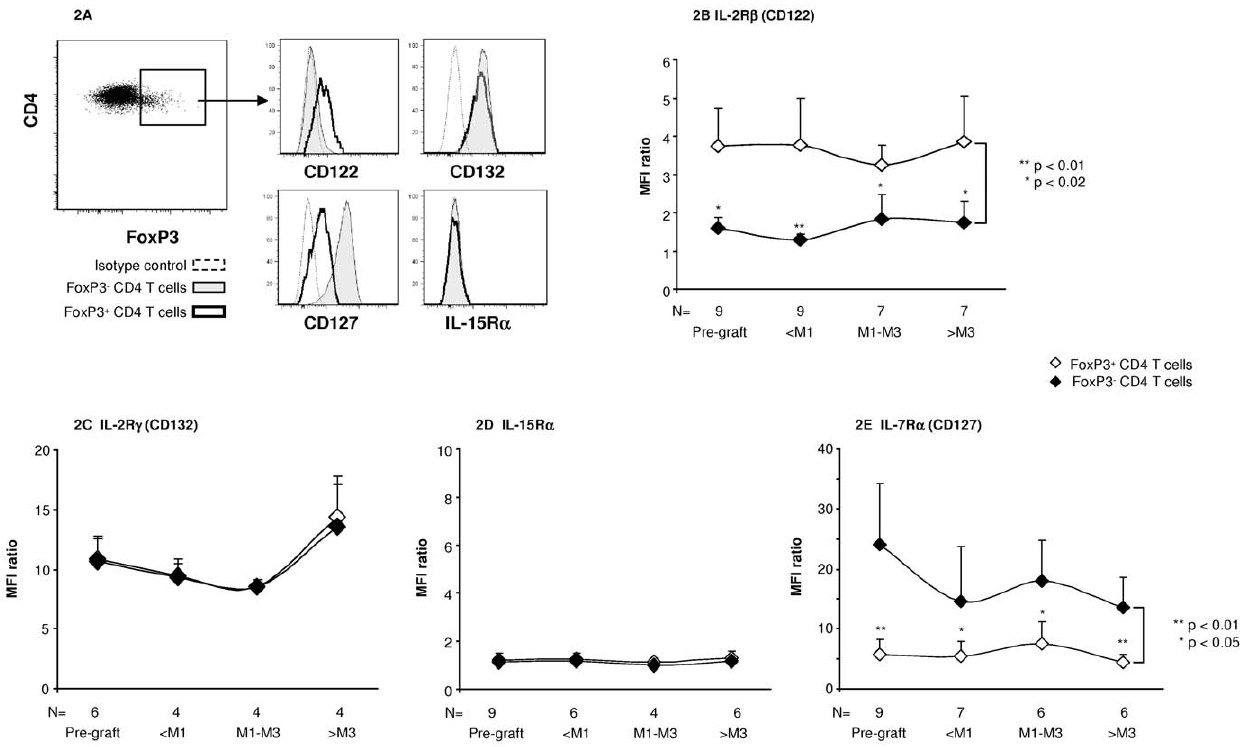
Figure 2. Human FoxP3 + CD4 T cells express high levels of IL-2 R b . IL-2R b ( Fig. 2A, 2B ), IL-2R c ( Fig. 2A, 2C ), IL-15R a ( Fig. 2A, 2D ) and IL- 7R a ( Fig. 2A, 2E ) expression was analyzed by flow cytometry in FoxP3 + and FoxP3 2 CD4 T cells before liver grafting and basiliximab injection (Figs. 2B to 2E), and at various times thereafter (2B to 2E). Fig. A shows a representative pre-graft staining profile. Figs. 2B to 2E represent the mean (SEM) MFI ratios (see Methods). The Wilcoxon test was used to compare FoxP3 + and FoxP3 2 CD4 T cells. The Mann Whitney test was used to analyze the time course of expression in a given cell subset. Only significant differences are indicated.